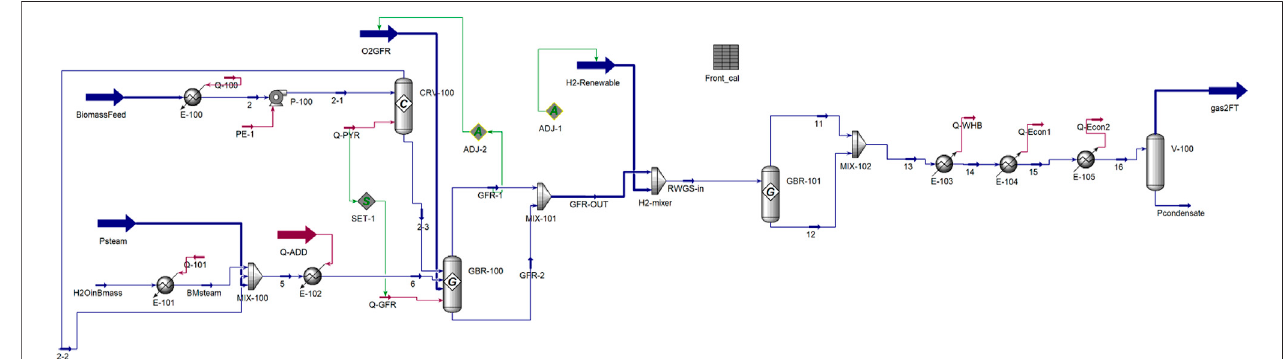
FIGURE 3 | Aspen Hysys implementation of the process.